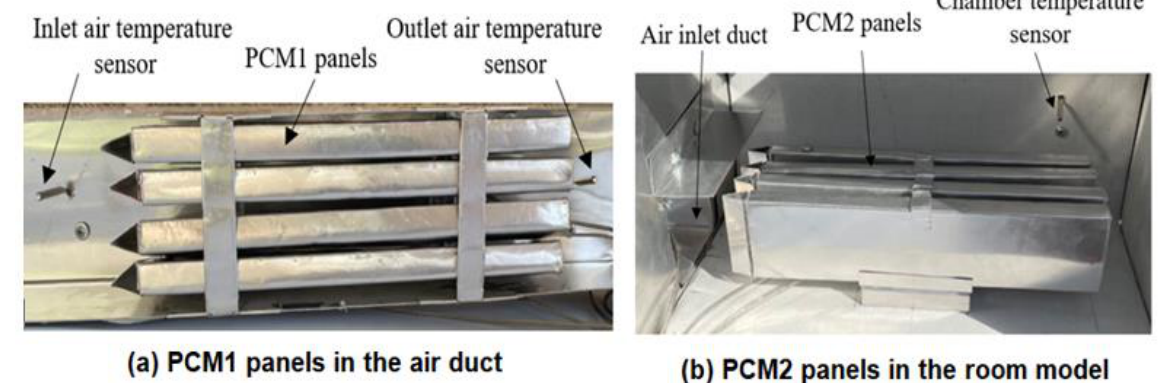
Figure 3. Encapsulated PCM rectangular aluminum panels: ( a ) PCM1 and ( b ) PCM2.